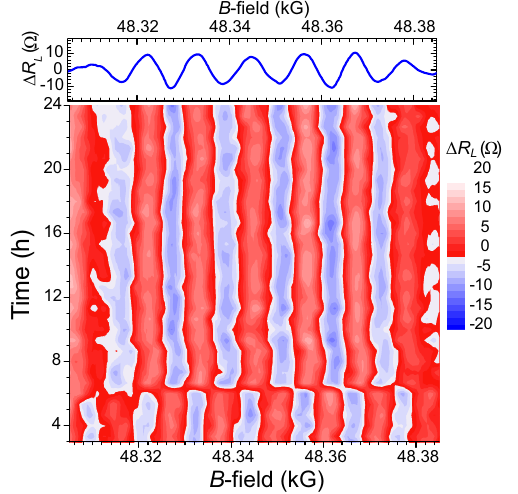
FIG. 8. Color plot of Δ R as a function of the magnetic field L ( x axis) and time in hours ( y axis) for a representative interference measurement near ν ¼ 7 = 2 . This plot represents the total of 76 up and down magnetic field sweeps similar to those of Fig. 3(b) (for a different sample preparation) but with the background sub- tracted, plotted as a function of the time to demonstrate the stability of the oscillations. A π phase jump occurs at about 6 hours, and for the following 18 hours the oscillation set is stable (sample 6, preparation 25, device type b, T ∼ 25 mK).